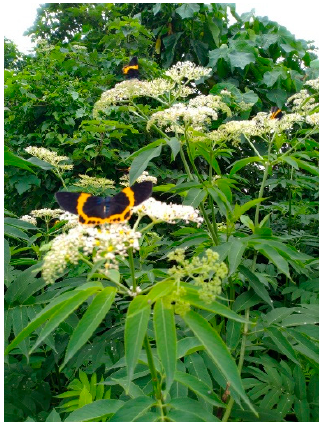
Figure 1. The appearance of Sambucus formosana.